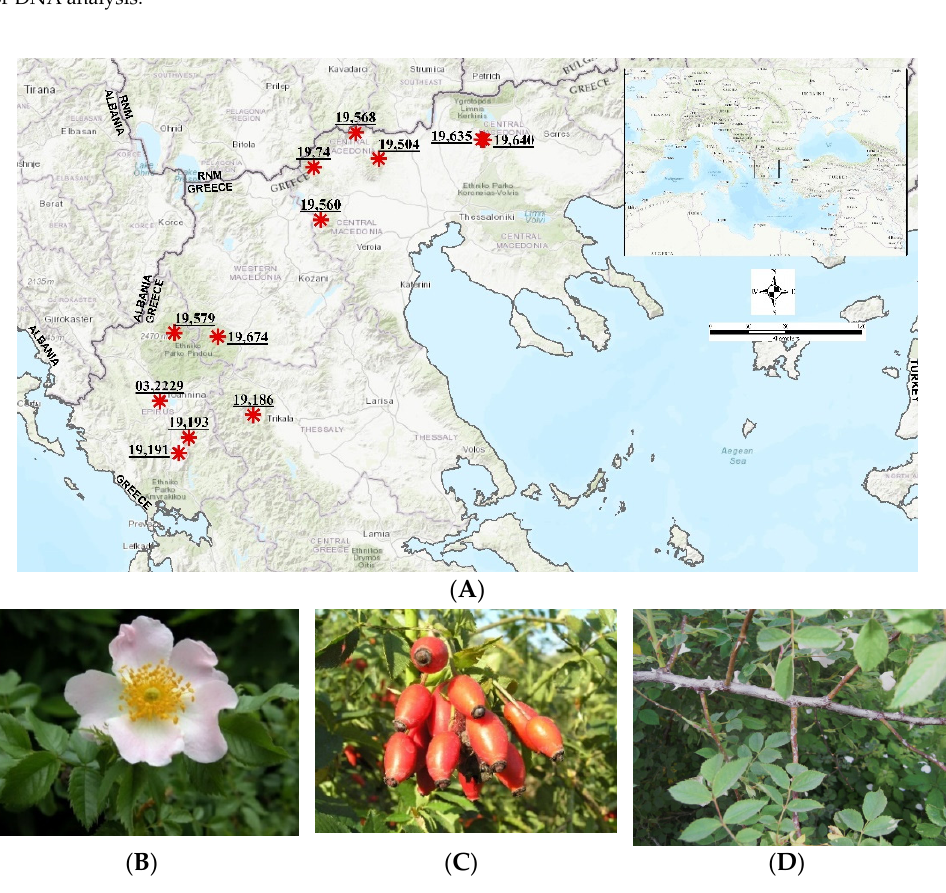
Figure 3. Overview of the collection sites of the Rosa canina Greek native germplasm analyzed ( A ), and morphology of flowers ( B ), fruits ( C ), and leaves ( D ) of R. canina GR-1-BBGK-03,2229 used for taxonomic identification, phytochemical analysis and DNA barcoding, respectively (for IPEN ac- cession numbers see Table